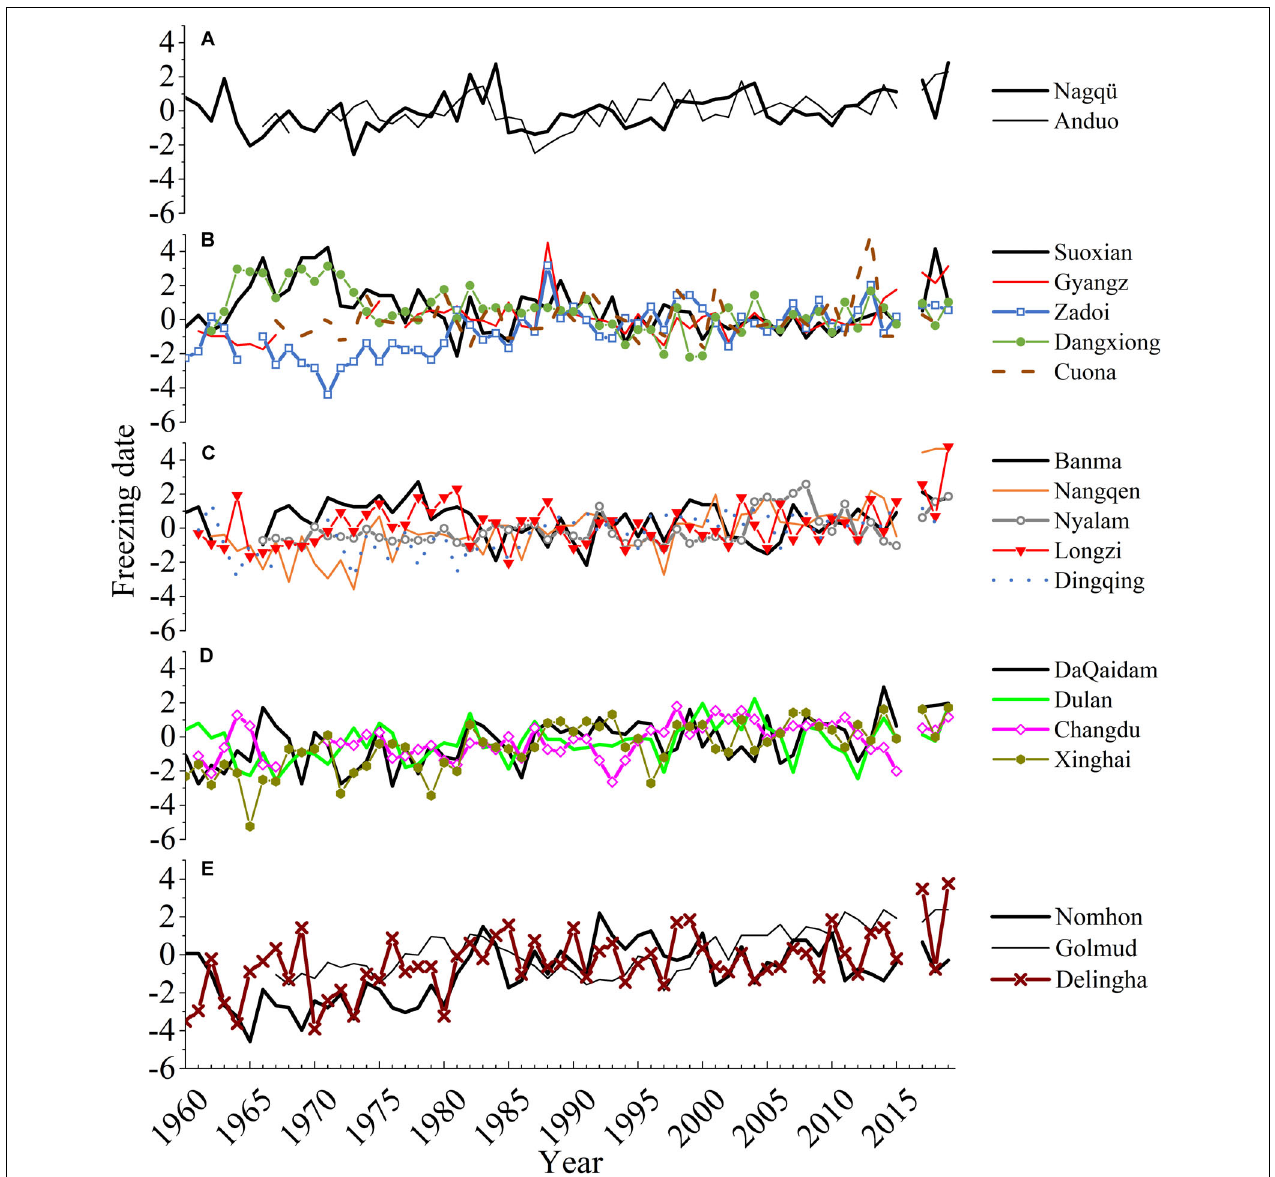
FIGURE 4 | Similar to Figure 3 , but for the onset date of ground